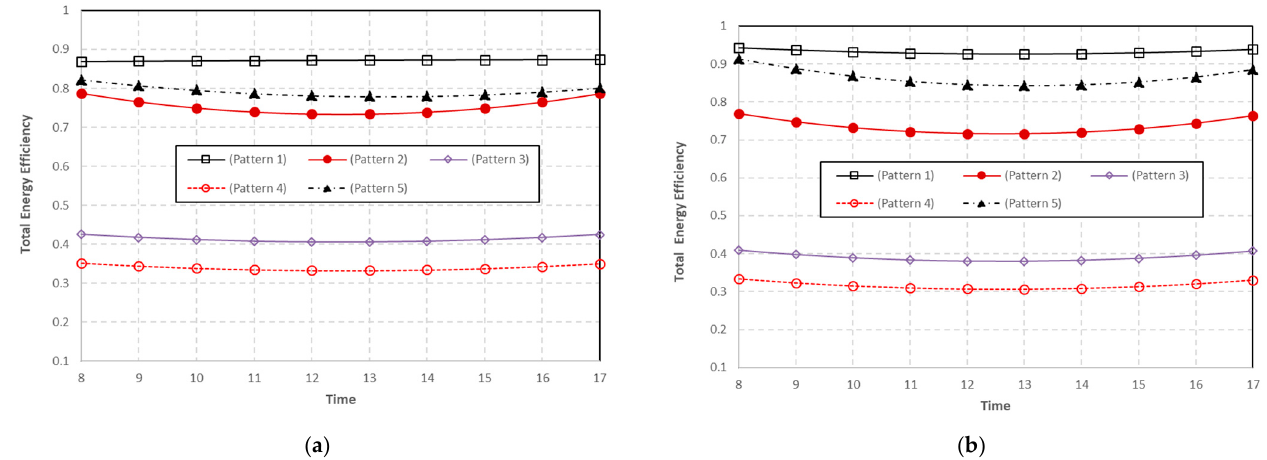
Figure 15. Hourly variations in the e ffi ciency of total energy of PVT system for di ff erent con fi gura- tions. ( a ) during Winter day ( b ) during Summer day.